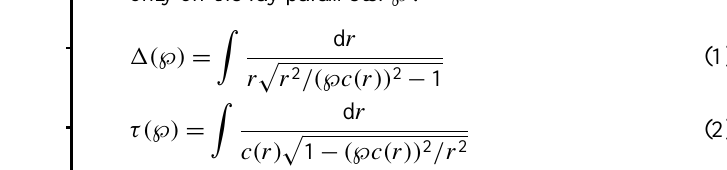
Fig. 2. Triplication of P -wave traveltimes in IASP91 . The triplica- tion C to D is produced by the discontinuity at 410 km depth, the one from E to F by the one at 660 km. The AB triplication origi- nates from the 210 km discontinuity, which is only of second order in IASP91 . This triplication can hardly be observed, especially since it overlaps with the one from 410 km. 2001). Strictly speaking, the approximation only holds for the case of a non-dispersive medium. Even when the medium is not intrinsically dispersive, velocity heterogeneities may introduce a frequency-dependent group velocity, which is the motivation for finite-frequency